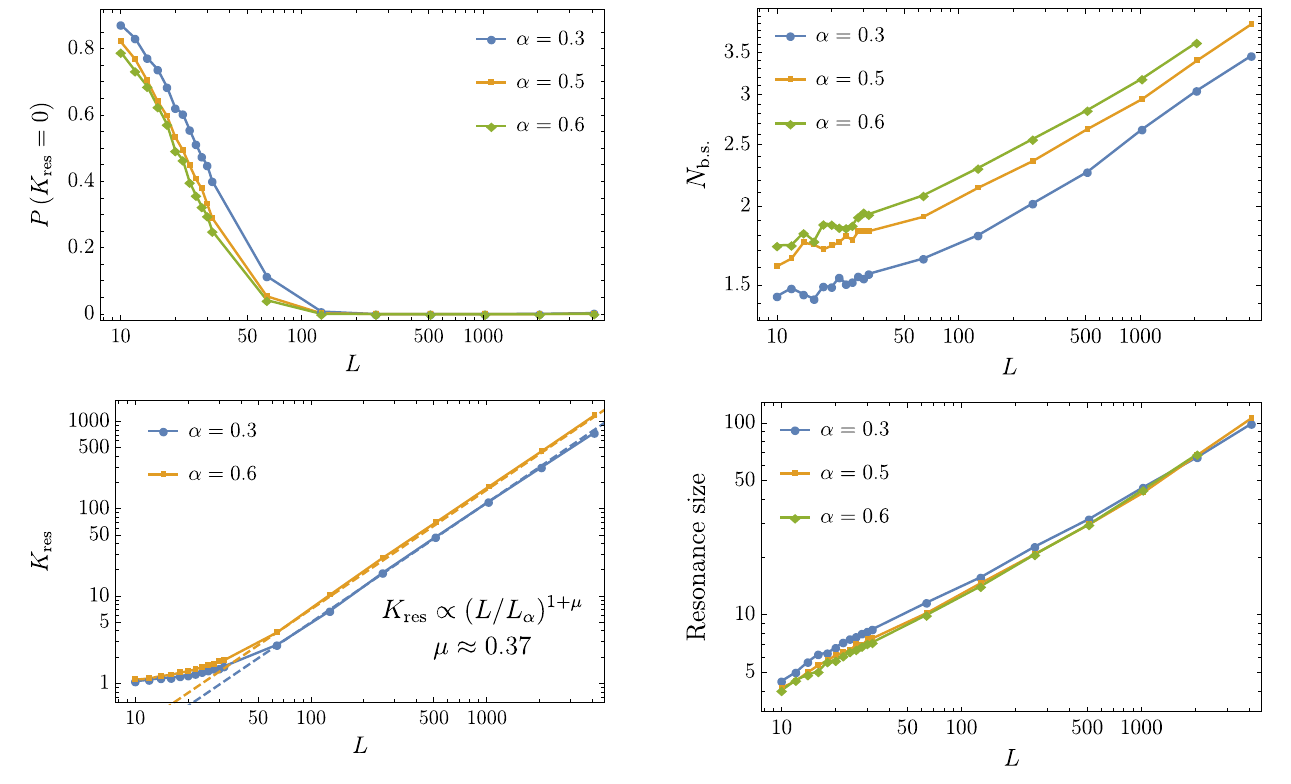
0 Þ for an SDRG tree FIG. 13. (Top) The probability P ð K res ¼ FIG. 14. (Top) Average number of the block spins changing state to have no resonant neighbors, as a function of the system their value in a single resonant transition. (Bottom) Typical size, and for different values of disorder (see the legend). Note the number of adjacent physical spins involved in a resonance (see logarithmic scale along the horizontal axis. While short systems the main text). are essentially free of resonances even for a relatively weak 0 Þ becomes vanishingly small disorder, the probability P ð K res ¼ in long systems. (Bottom) Typical number of resonant neighbors for an SDRG tree state in long systems L ≤ 2 12 . The three solid lines of different colors correspond to the two different values of the exponent α ¼ 0 . 3 , 0.6. The dashed lines show the power-law L=L 1 ð α Þ(cid:3) 1 þ μ . The scale L 1 ð α Þ where the average fits, K res ¼ ½ number of resonant neighbors for an SDRG tree state equals 1 is defined in the previous subsection.